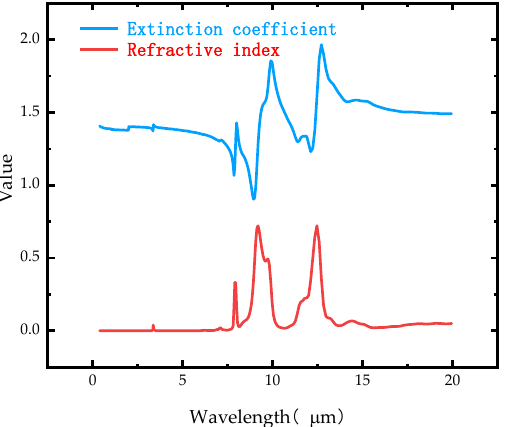
Figure 2. Refractive index n and extinction coefficient k of PDMS material.